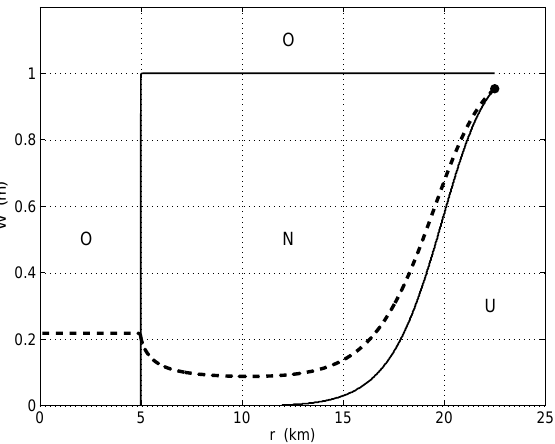
Figure 3. A nearly exact radial, steady solution for pressure P(r) (dashed) and overburden pressure P o